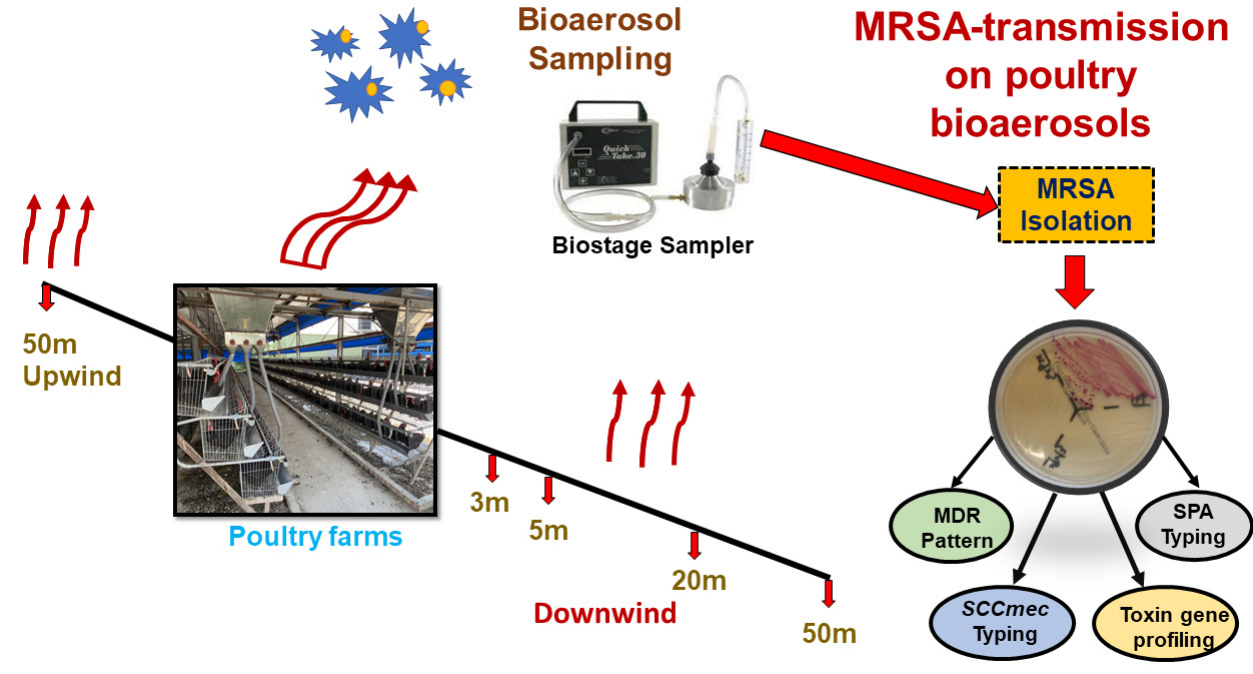
Figure 1. Schematic diagram of study design and chicken farm bioaerosol sampling strategy.